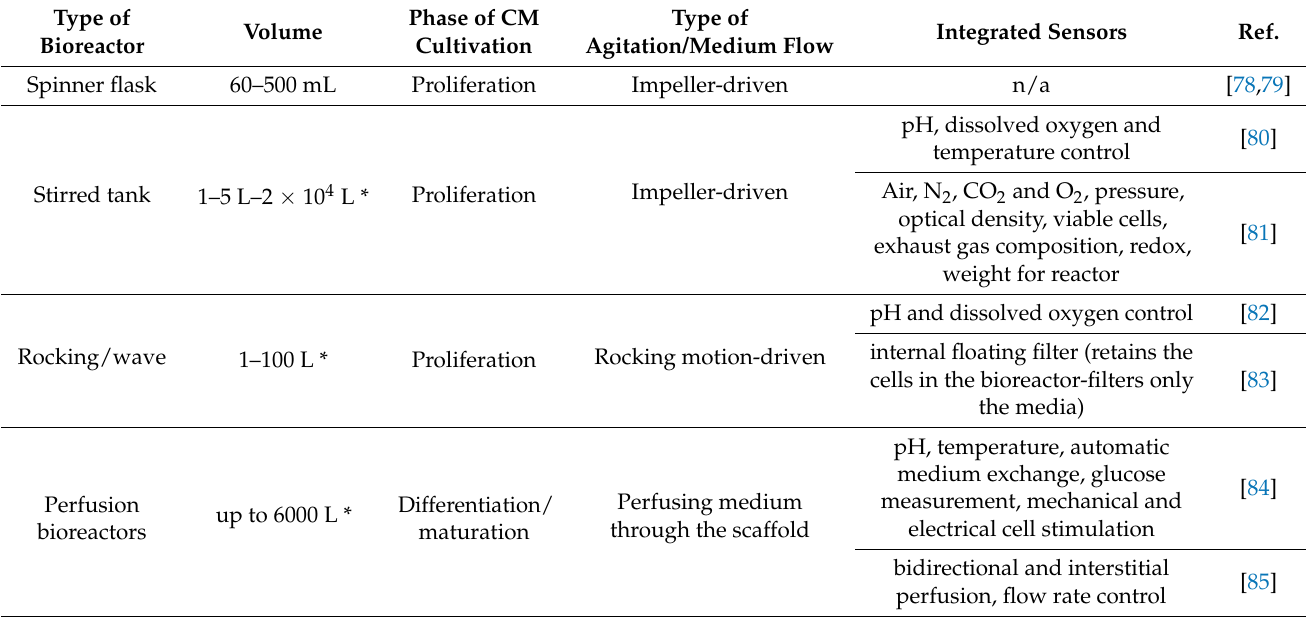
Table 1. Main types of commercially available